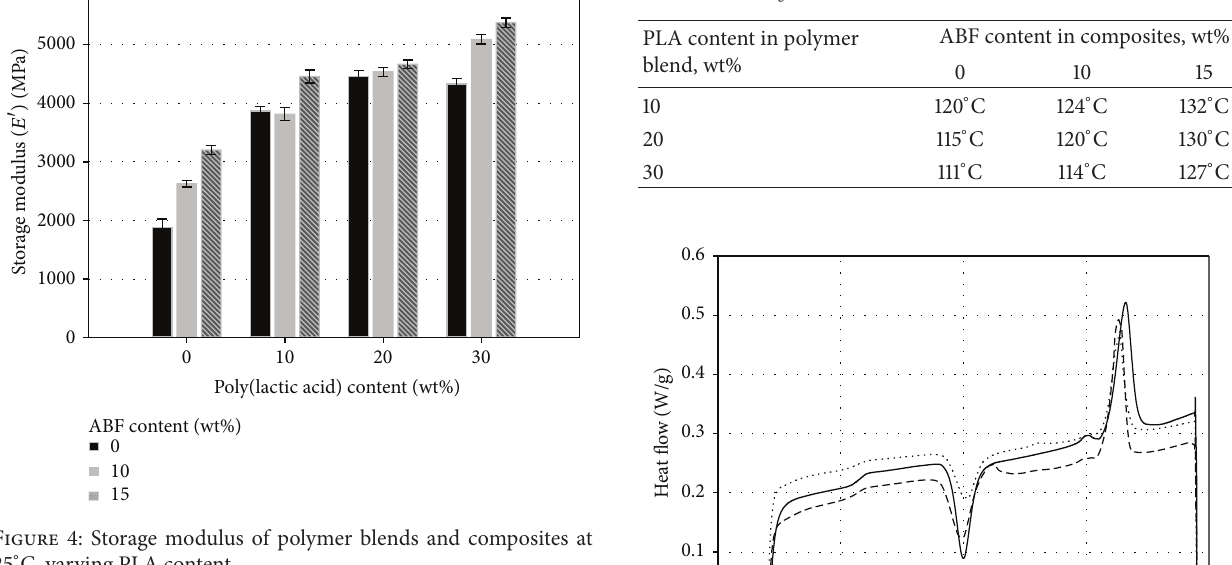
Table 2: 𝑇 𝑔 of starch in polymer blends and composites.